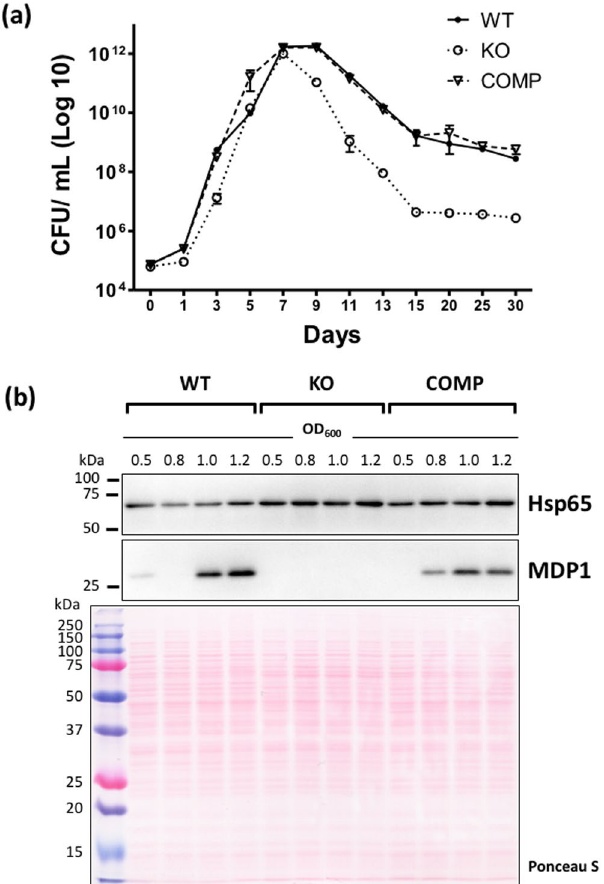
Figure 1. MDP1-KO rapidly dies after entering stationary phase. ( a ) Growth curve of M. smegmatis WT, MDP1-KO, and COMP strains over 30 days represented as colony forming units (CFUs)/ml of culture. Bacteria were grown at 37 °C in 7H9-ADC medium with stirring at 60 rpm under normoxia. Data is shown as a representative of duplicate experiments. ( b ) Western blot indicating the expression levels of MDP1 in WT, MDP1-KO (KO), and COMP strains at OD 600 values of 0.5, 0.8, 1.0, and 1.2. Ponceau S staining of transferred protein on the membrane were shown to confirm the loaded samples have the same amount of proteins and protein bands proved with anti Hsp65 antibody were shown as the internal